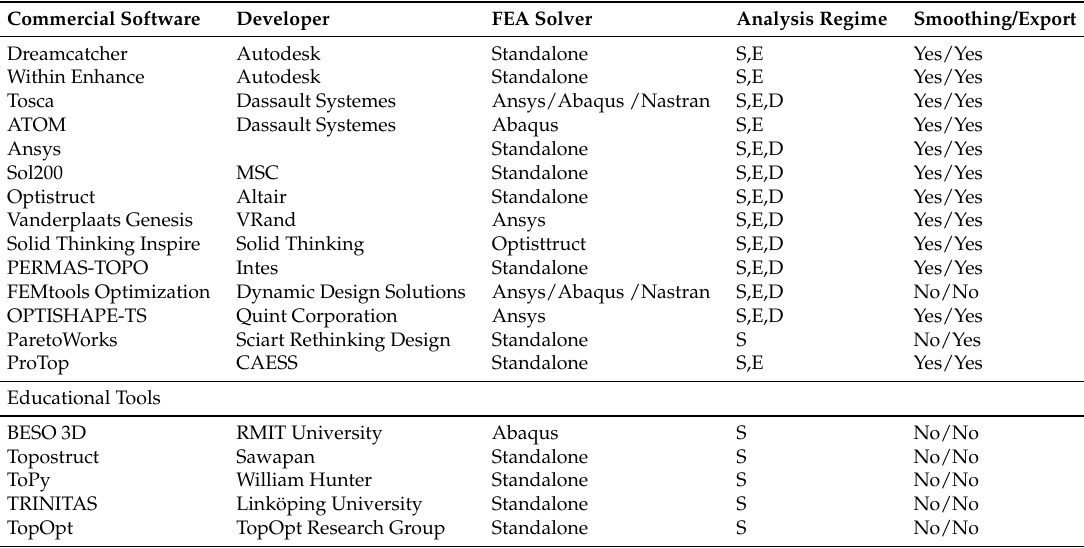
Table 5. Overview of Topology Optimization (TO) software: commercial and educational [78]. Its developer, Finite Element Analysis (FEA) solver, analysis regimes (S—Static; E—Eigenvalues; and D—Dynamic Loading) and the existence of post-processing tools (smoothing and export) are also